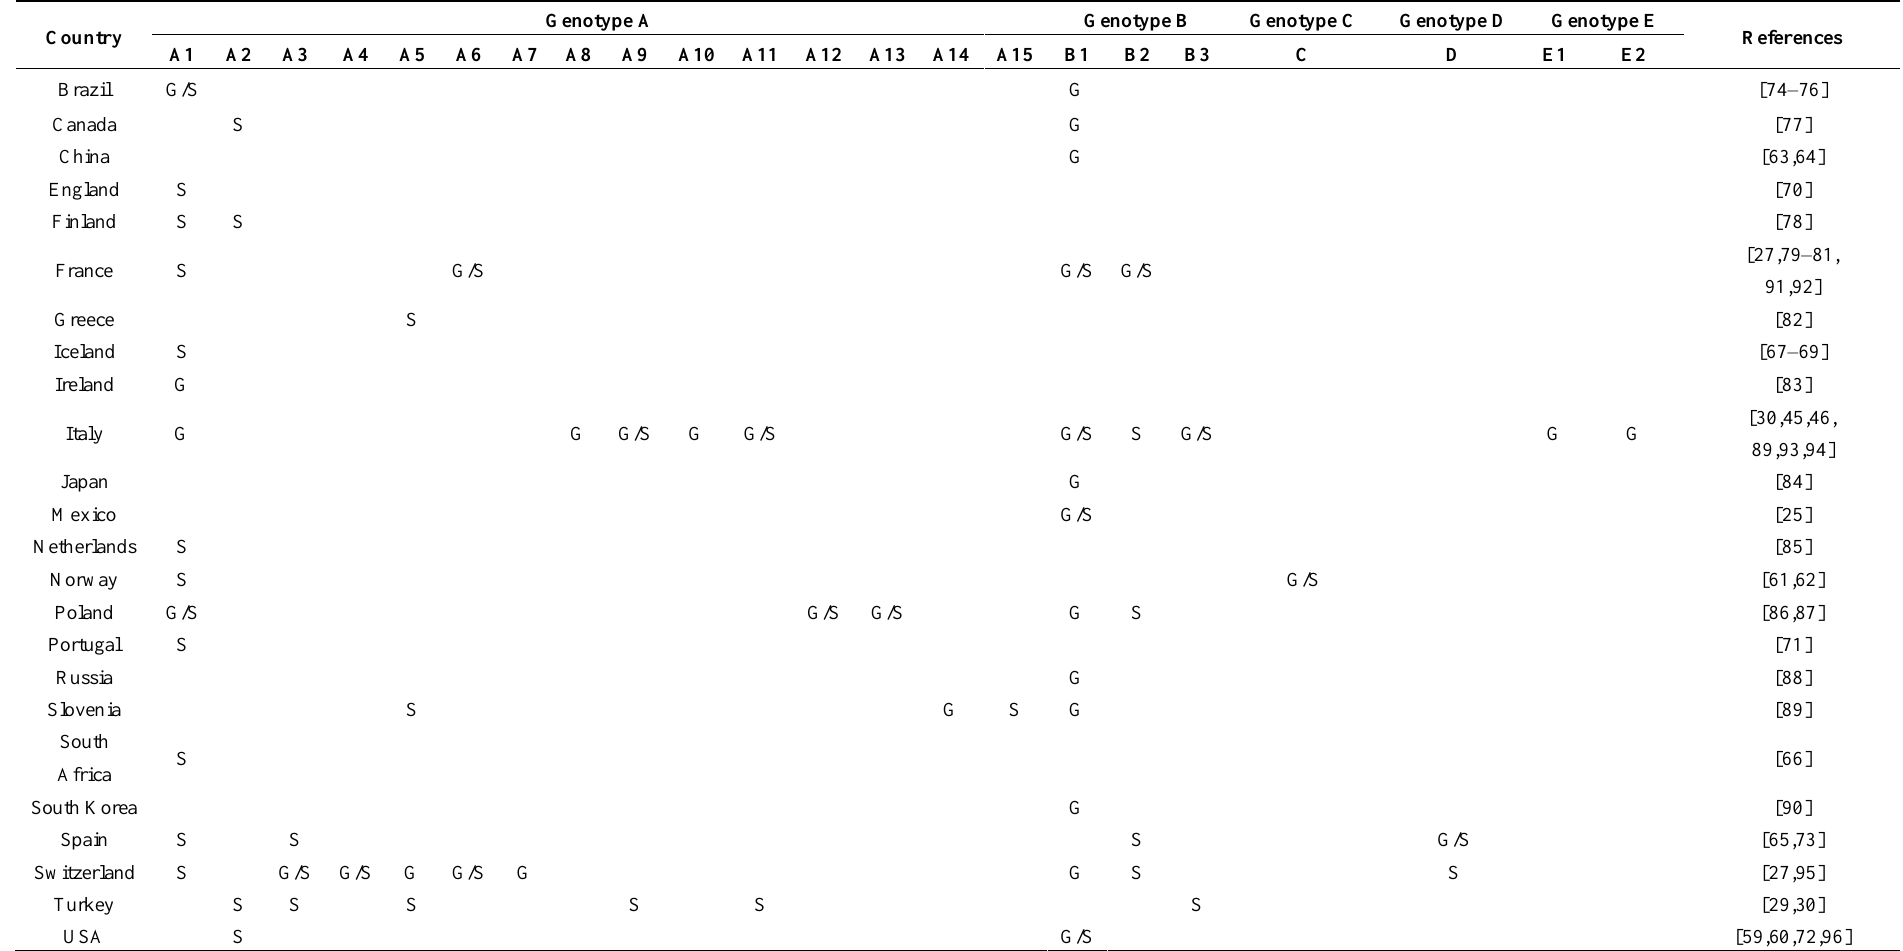
Table 1. Distribution of SRLV genotypes and subtypes which infect goats and sheep from different